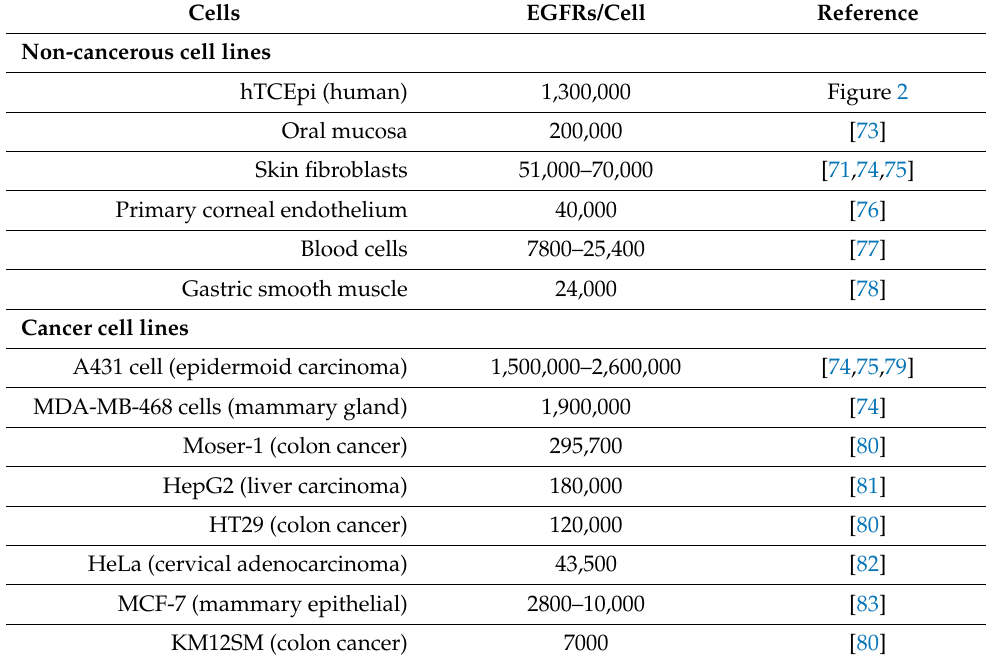
Table 1. EGFR density in selected cell lines.